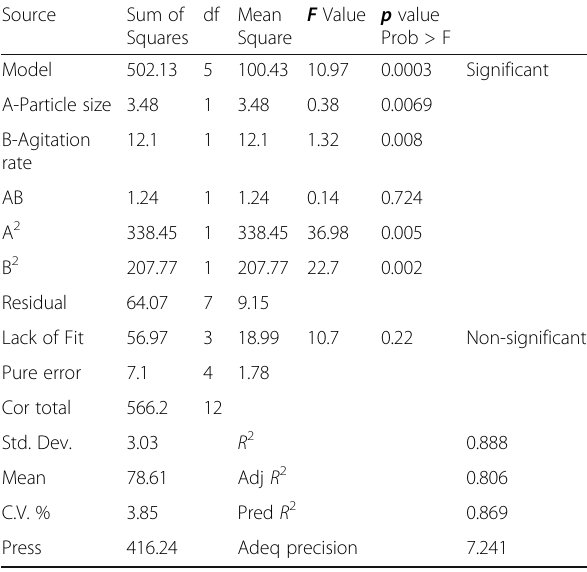
Table 5 ANOVA for response surface quadratic